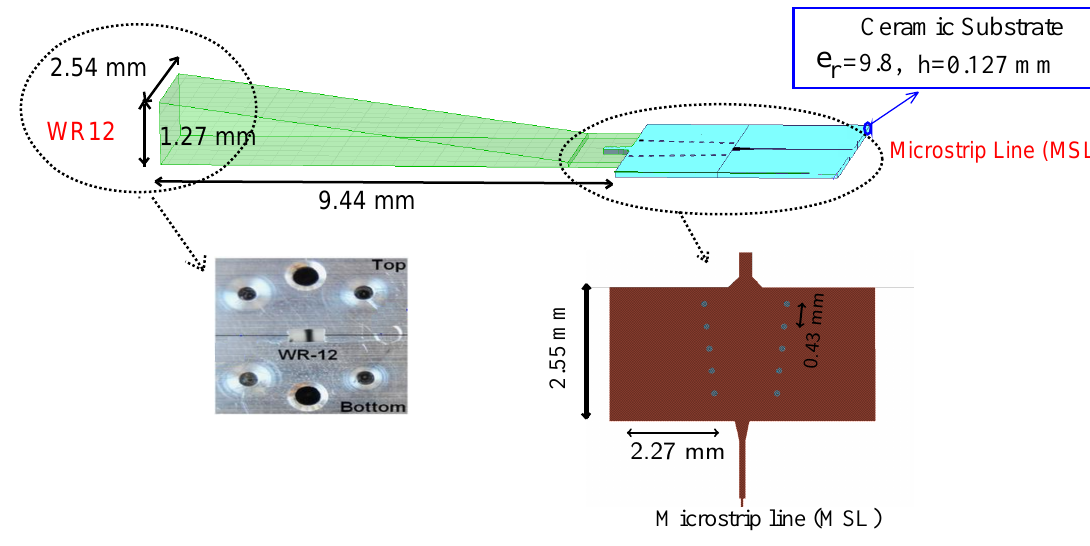
Figure 9. WR-12 rectangular waveguide to microstrip line transition.